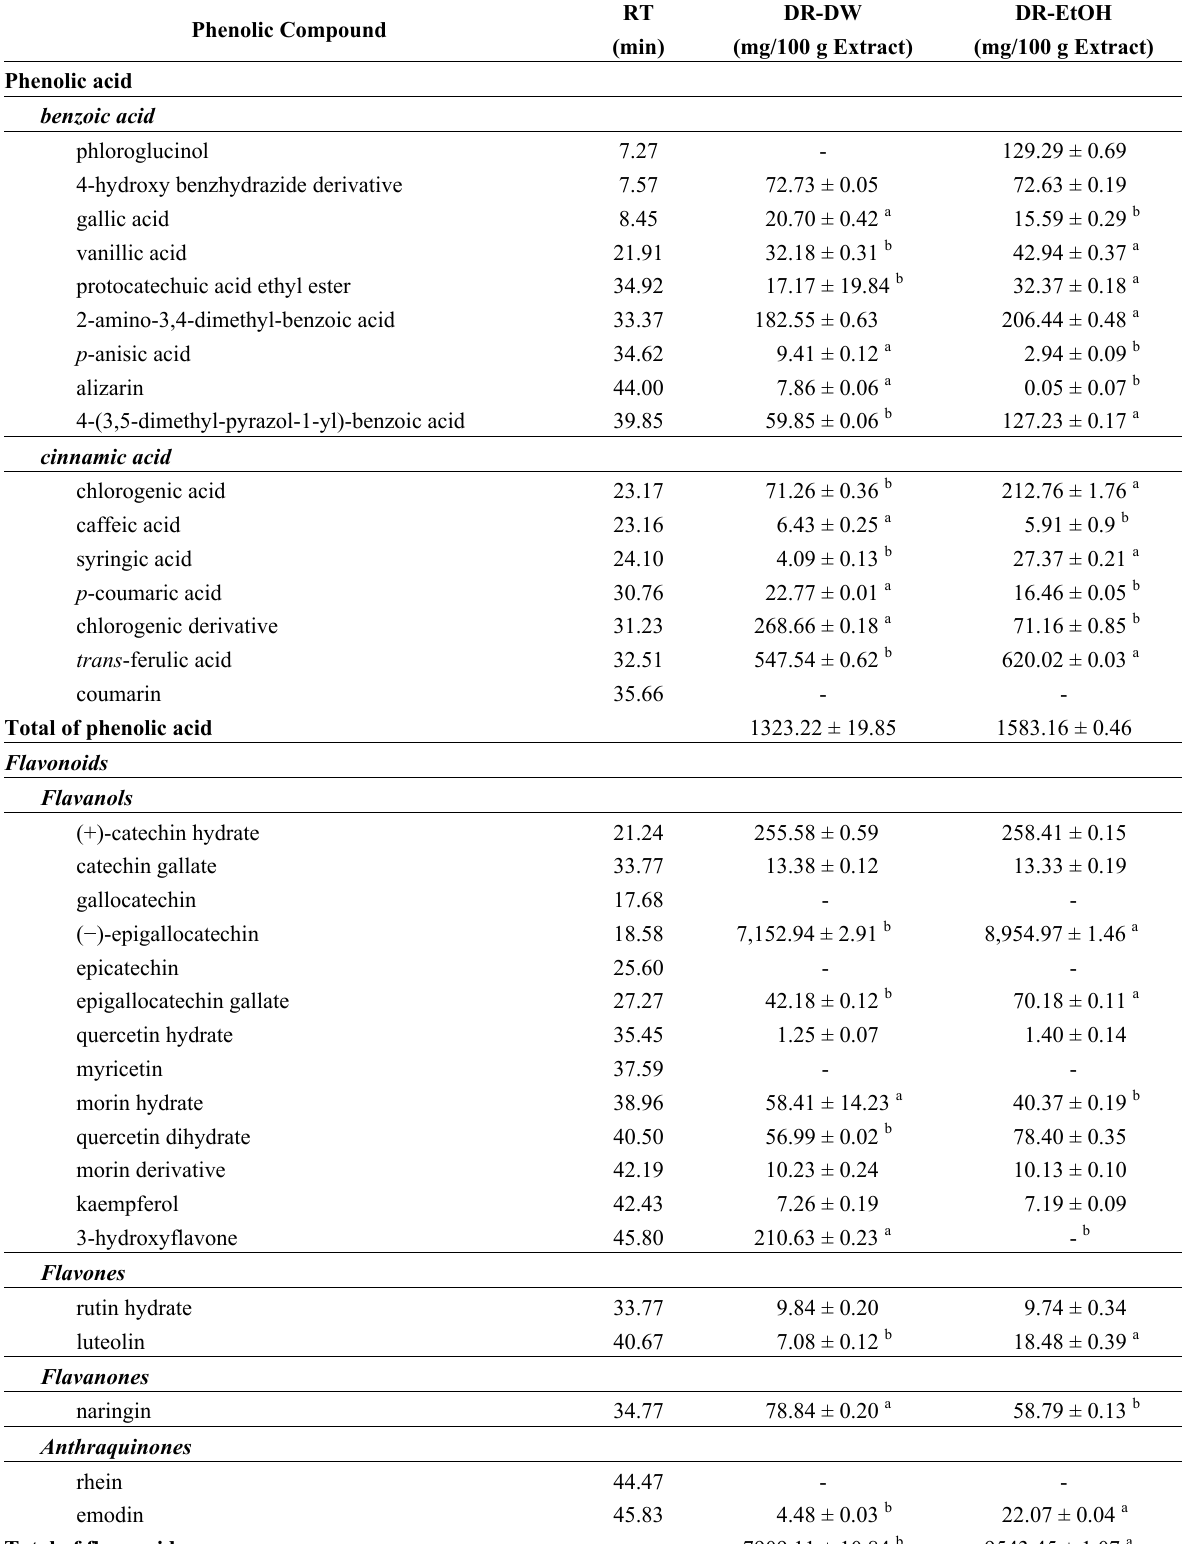
Table 1. Total phenolic and flavonoid contents (dry basis) of water and ethanol extracts from Drynariae rhizoma